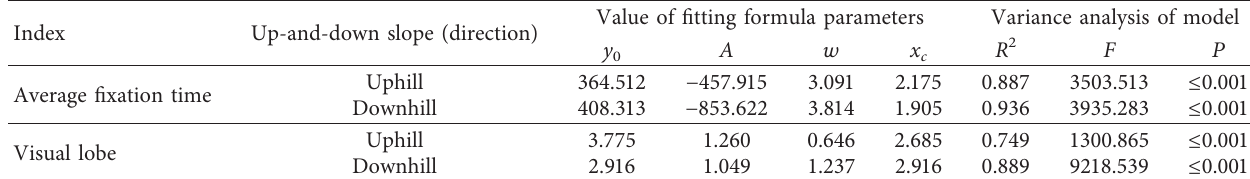
Figure 3: Curve fitting results of uphill and downhill sections. (a) The uphill average fixation time. (b) The downhill average fixation time. (c) The uphill visual lobe. (d) The downhill visual lobe. Table 8: Fitting formula parameters and fitting model